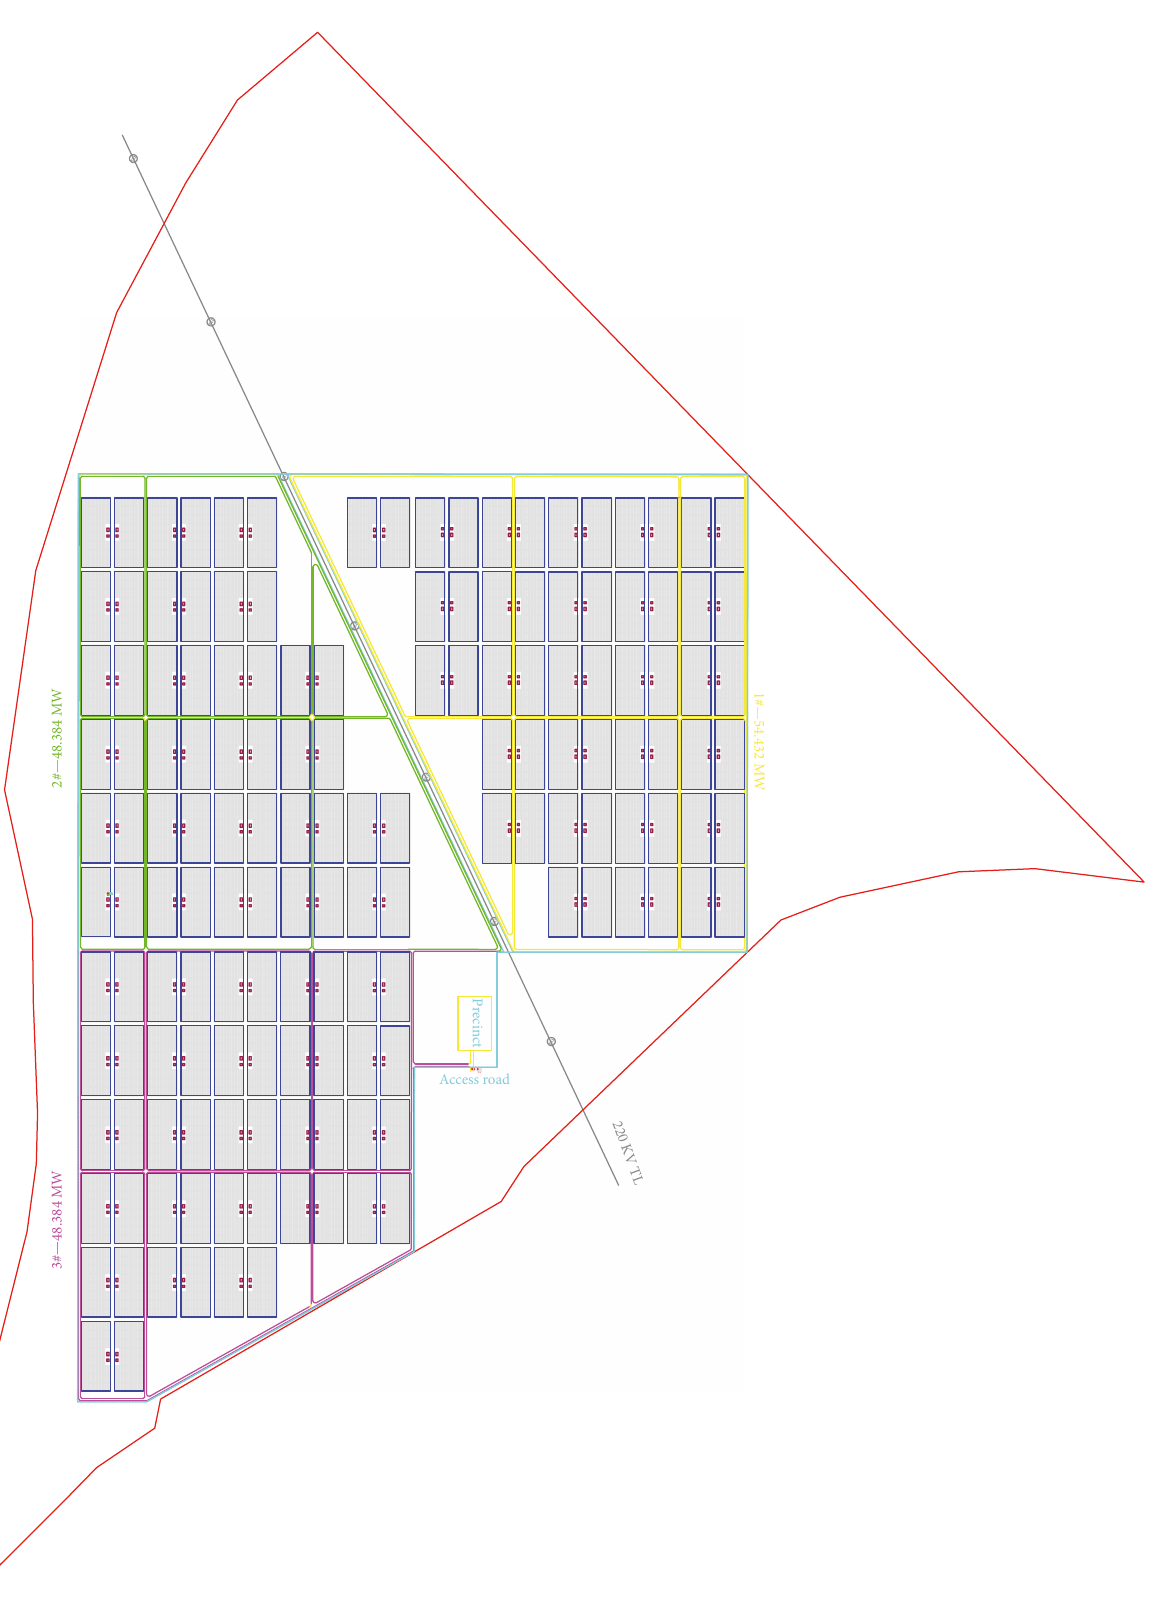
Figure 13: 3 × 50MW PV project overall drawing